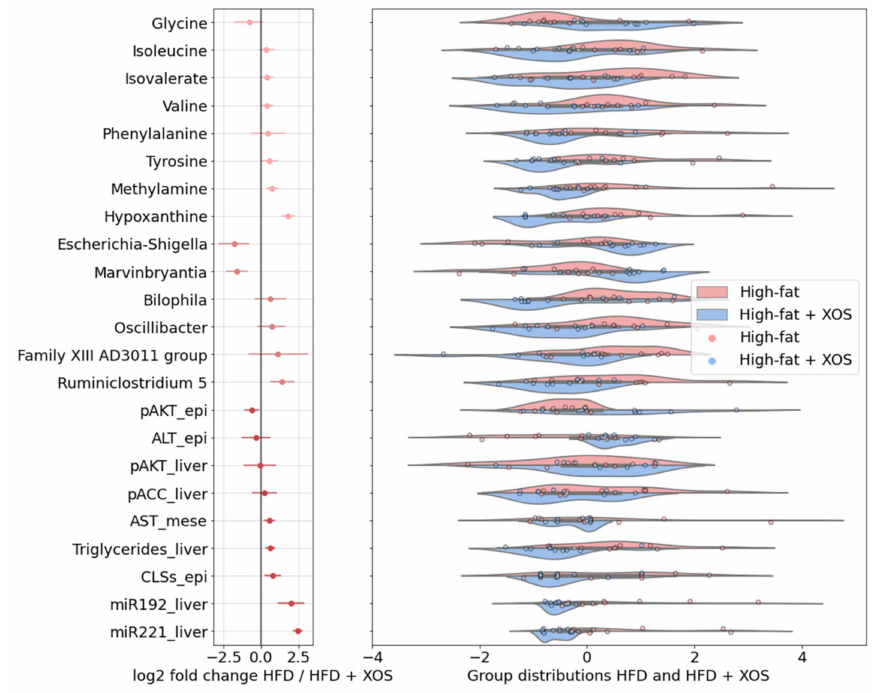
Figure 10. The features with significant differences between the HFD and HFD + XOS groups, log 2 fold changes and mean-centered values showing group distributions. Negative log 2 fold change indicates higher log 2 effect size with XOS, and positive indicates higher log 2 effect size without XOS. Bars indicate error. Kernel density bandwidth of the violin plot 0.5. epi = epididymal fat, mese = mesenteric